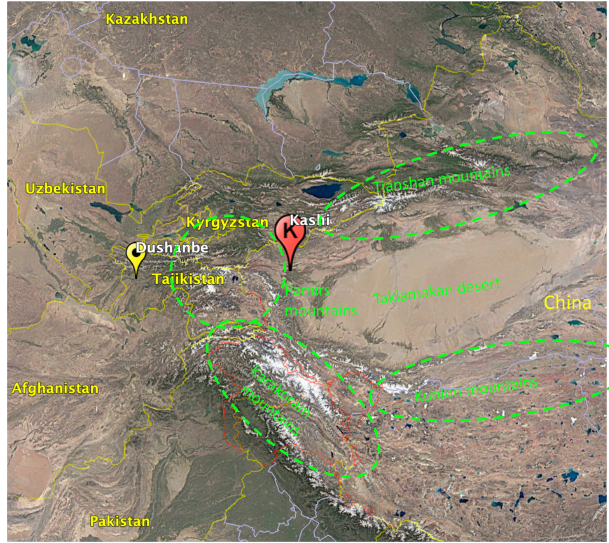
Figure 1. The location of the observation site in Kashi (at 39.51 ◦ N, 75.93 ◦ E). The observation site is about 628km to the east of Dushanbe, Tajikistan (38.53 ◦ N, 68.77 ◦ E). The green ellipses in- dicate the mountain ranges surrounding the Taklamakan desert, in- cluding the Tianshan mountains, the Pamir mountains, the Karako- ram mountains, and the Kunlun and Altun mountains. ©